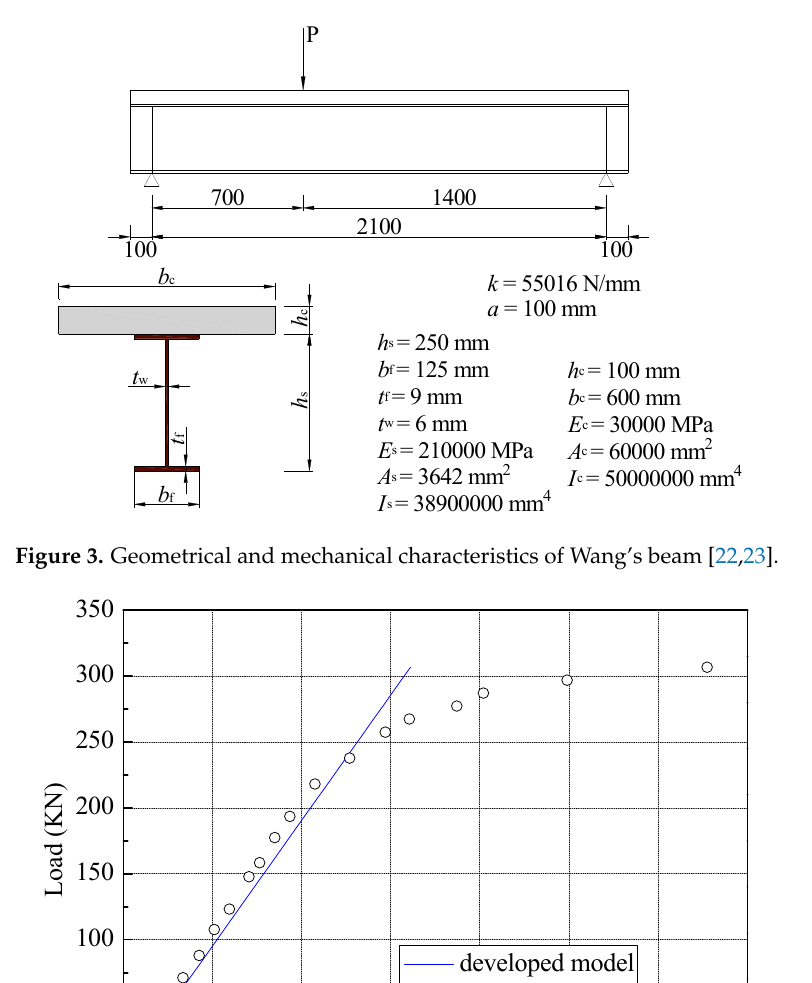
Figure 4. Load-deflection curves.